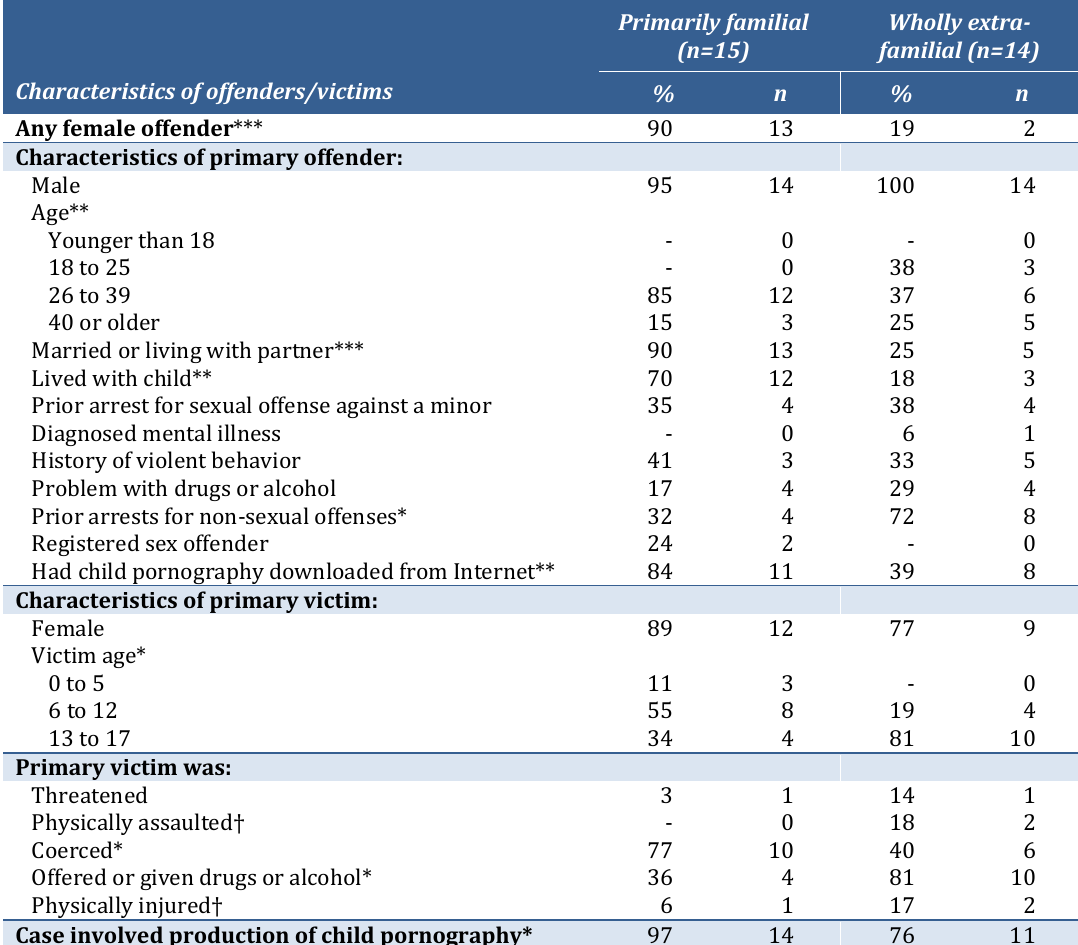
Table 3: Technology ‐ facilitated organized abuse arrest cases: Primarily familial compared to wholly extra ‐ familial